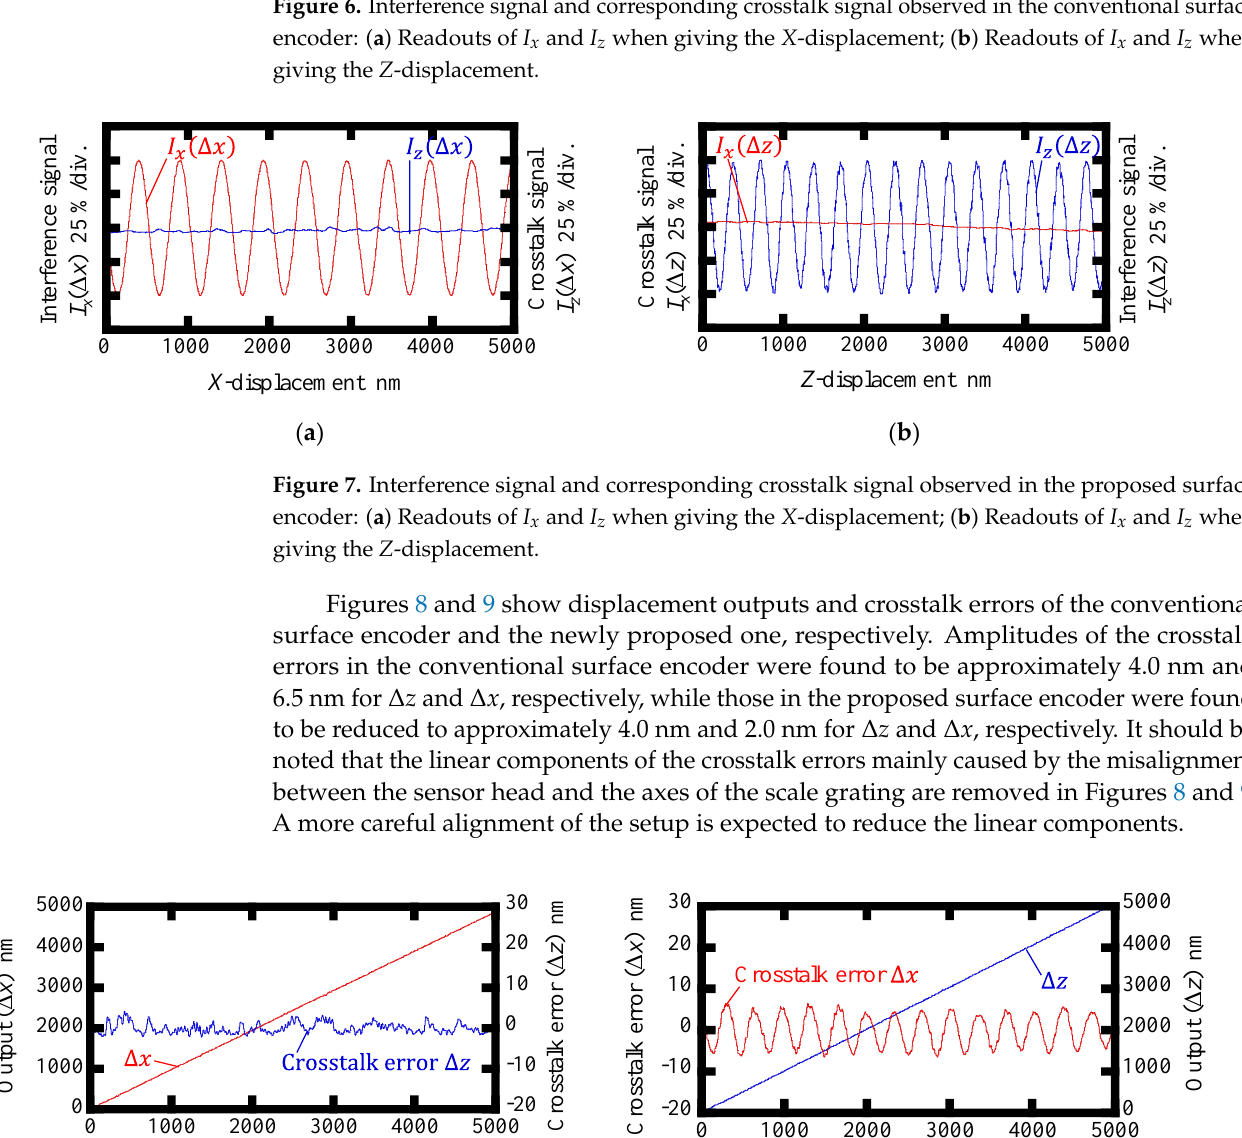
Figure 8. Crosstalk errors observed in the conventional surface encoder: ( a ) Readouts of Δ x and Δ z when giving the X -displacement; ( b ) Readouts of Δ x and Δ z when giving the Z -displacement.